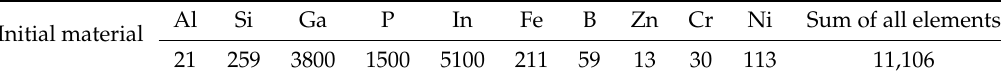
Table 3. Initial chemical analysis of germanium, via ICP-OES (ppm).